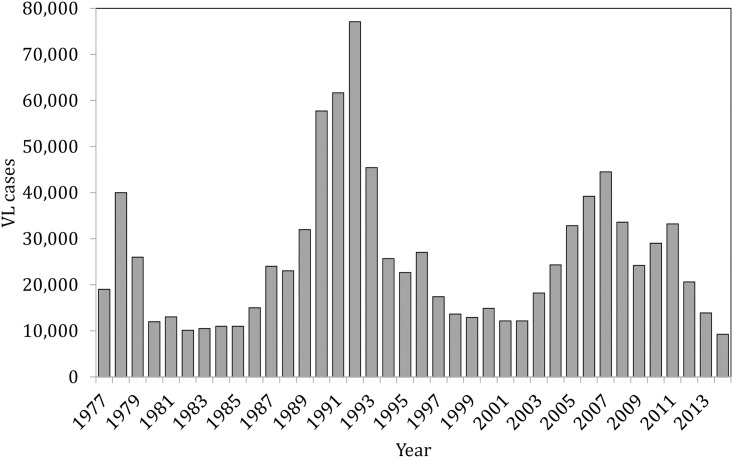
Reported cases of visceral leishmaniasis in India from 1977 to 2014.Data 1977–1985 are from Bihar only; data from 1986 onward include all reported cases in India. Source of data: Ministry of Health and Family Welfare, Government of India, as published in [17, 18].